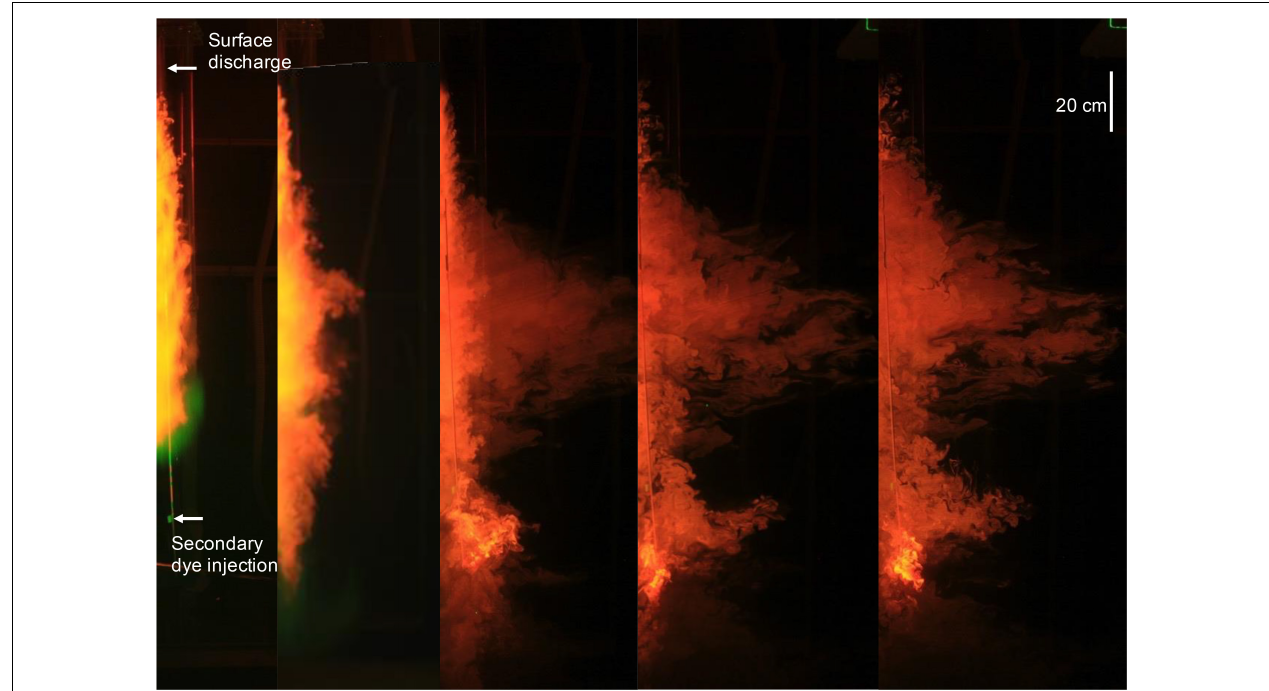
FIGURE 5 | The time revolution of an experimental plume released from the surface ∼ 2.2 m above the tank floor. The development of one side of the plume profile (plume is axisymmetric) with time is shown from left to right.